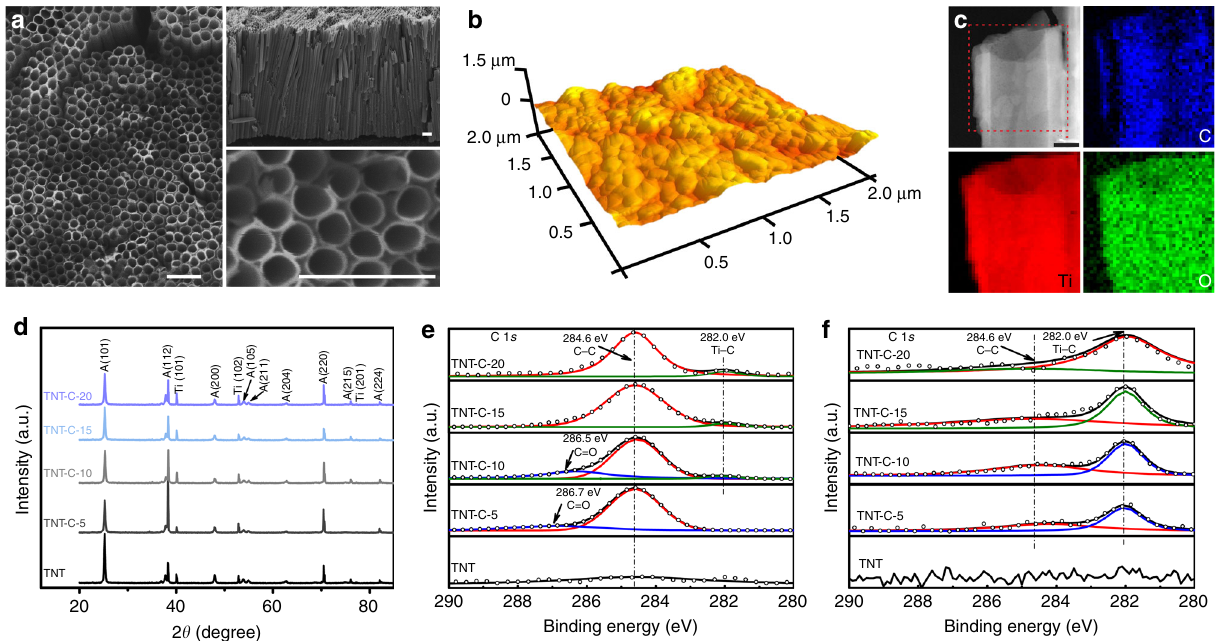
Fig. 1 Representative sample characterization results. a SEM image of TNT-C-15 with the insets showing the corresponding enlarged and cross-sectional images (Scale bar = 500 nm). b AFM image of TNT-C-15 showing the surface morphology. c STEM-EELS maps of C, Ti, and O of TNT-C-15 (Scale bar = 50 nm). d XRD patterns of the TNT and TNT-C samples. e , f High-resolution C 1 s spectra of the TNT and TNT-C samples acquired e from the surface and f after sputtering for 6 min. The sputtering rate is approximately 21 nm min − 1 referenced to SiO